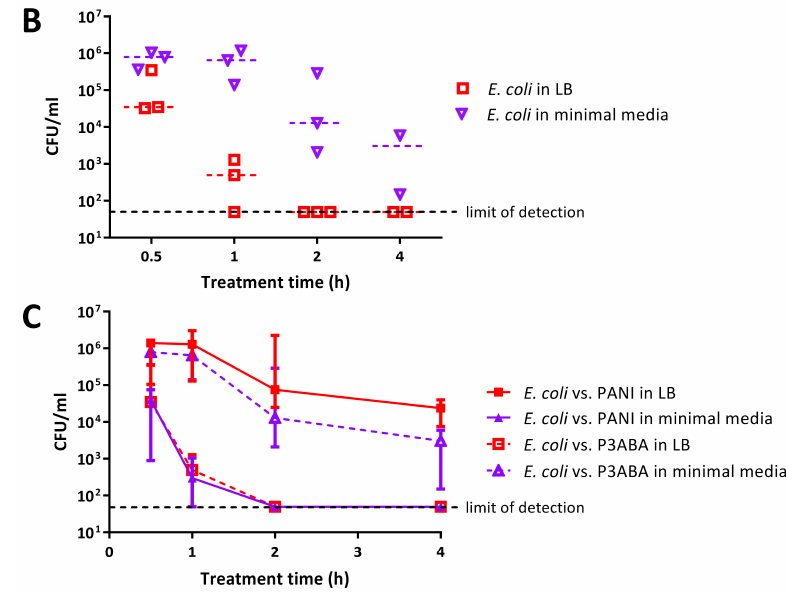
Figure 3. Sensitivity of E. coli 25922 lux to PANI and P3ABA suspensions in rich and minimal media. Cell viability assays of ~10 6 CFU/mL E. coli treated with 0.5% PANI suspension ( A ) and 0.5% P3ABA suspension ( B ) in Lennox broth (LB) and minimal A salts, with each symbol representing the median of three technical replicates and the bar representing the median of each biological replicate. The data in A and B is replotted together in ( C ) where each point represents the median of biological replicates and the error bars are the range. Viable cell counts (CFU/mL) were obtained for experimental sample at 0.5 h, 1 h, 2 h, and 4 h time points. The limit of detection is 50 CFU/mL.